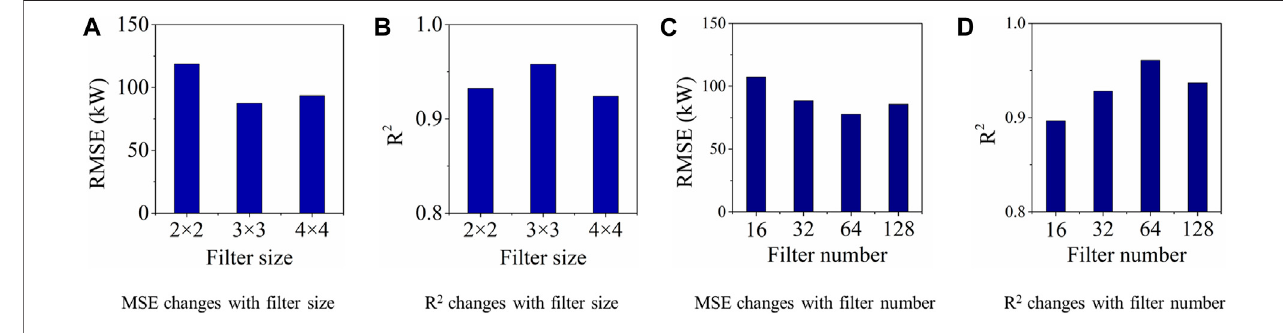
FIGURE 3 | Tuning the fi lter size and fi lter number for